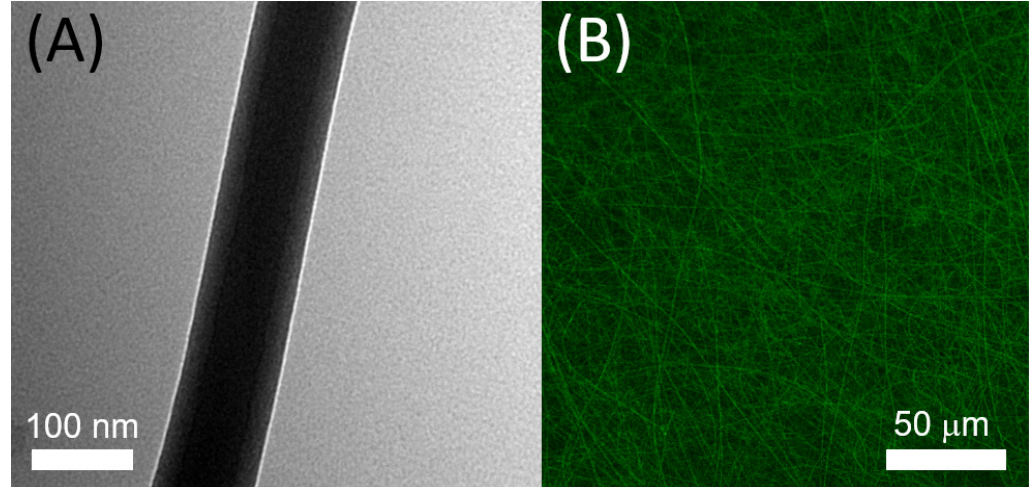
Figure 5. ( A ) TEM of sheath–core-structured nanofiber, ( B ) laser scanning confocal microscopic photo of reGFP in coaxially spun nanofibers.